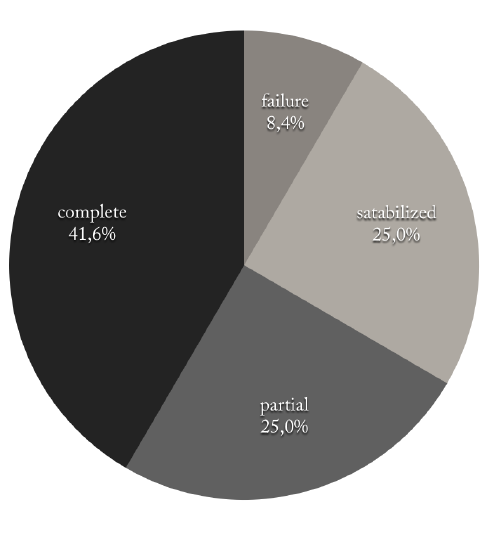
Figure 1 . Terbinafine: outcome of global clinical assessment by treatment (proportion of patients - 12)